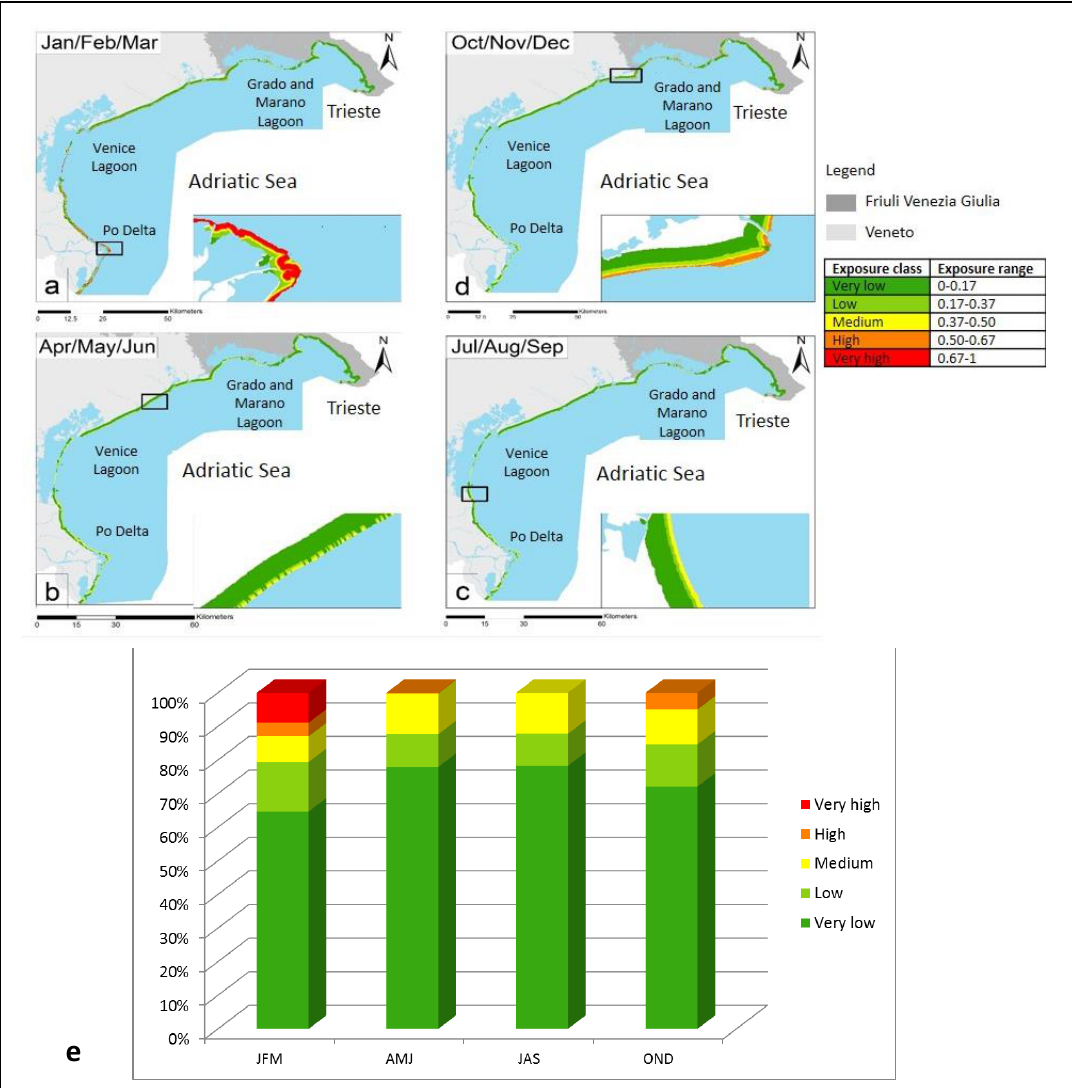
Figure 2. Exposure map ( a – d ); and distribution of the percentage of surface ( e ) associated with each exposure class for the North Adriatic coasts within the RICE area for the four seasons of the future scenario 2070–2100: January-February-March (JFM); April-May-June (AMJ); July-August-September (JAS); October-November-December (OND).